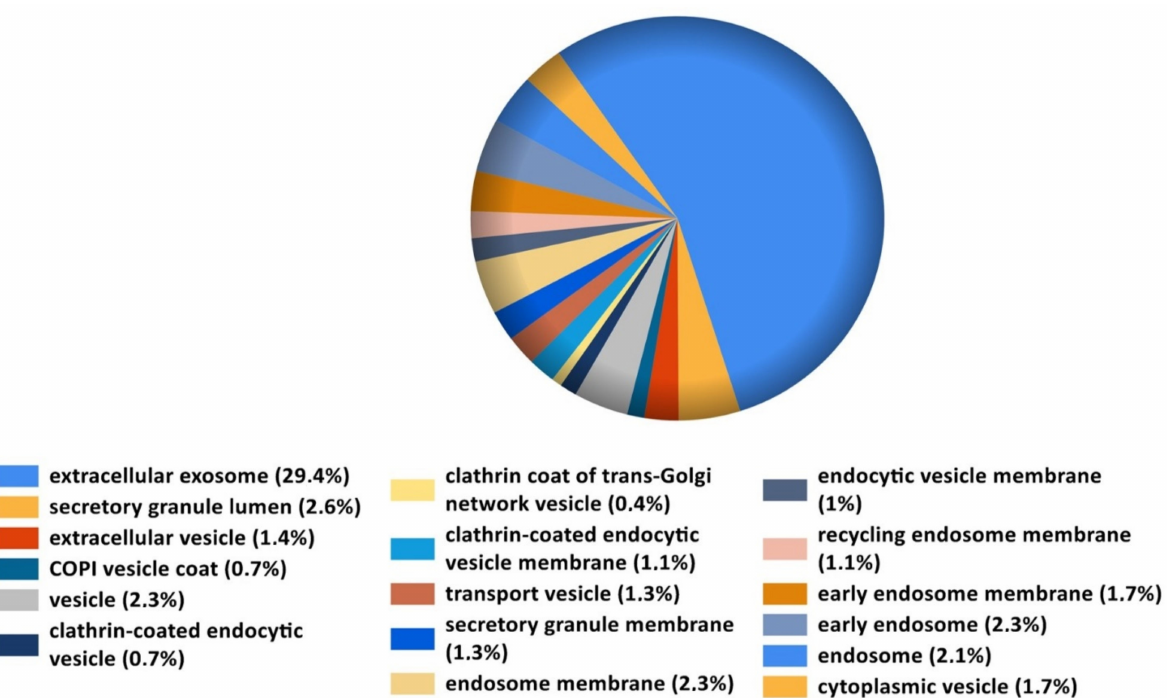
Figure 4. FunRich (Uniprot database) analyze of the proteins differentially expressed by E2 stimulation shows a significant over-representation (False Discovery Rate corrected p -value < 0.05) of the proteins participating in different cellular components and identified by Reactome pathways. The screening of the proteins involved in the paracrine function of the MSCs are represented as percentage (%) from the total of the cellular protein